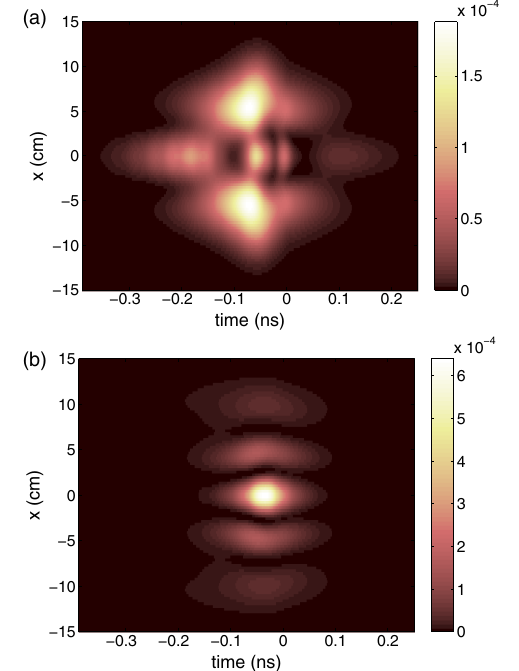
FIG. 8. The transverse temporal profiles of THz pulses at the undulator exit obtained at z with the cavity length detuned by δ L ¼ − 28 mm.